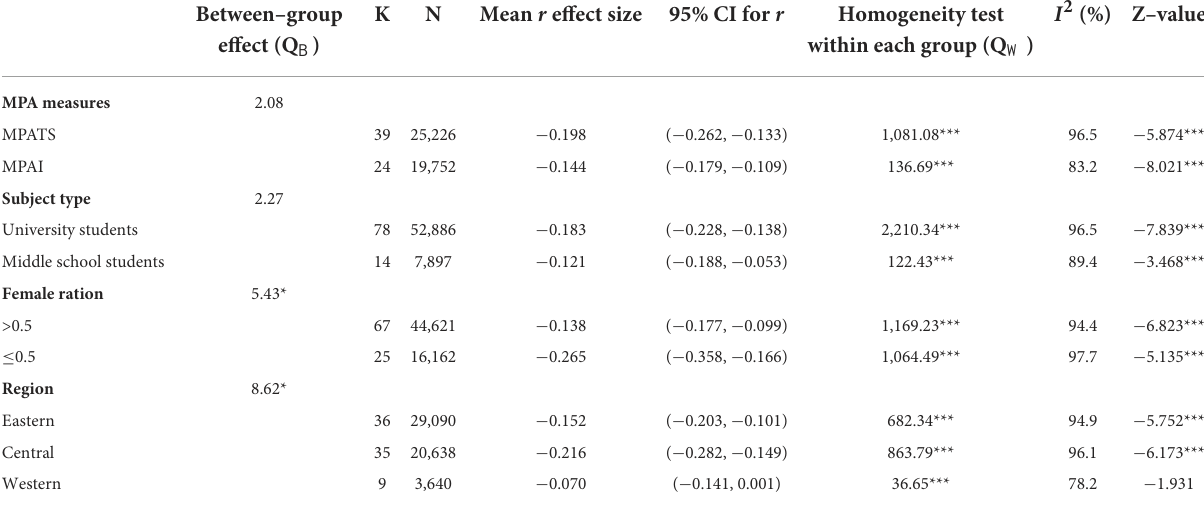
TABLE 4 MPA and social support: Univariate analysis of variance for moderator